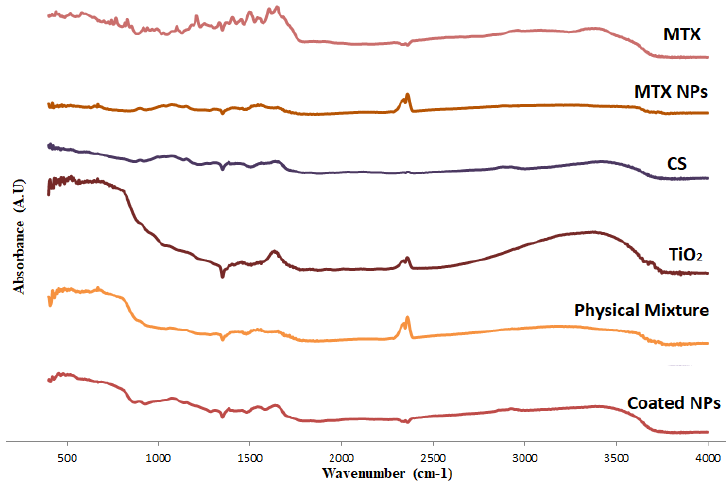
Figure 2. FTIR spectra of CS, MTX, TiO 2 NPs, CS-MTX NPs, the physical mixture (MTX-CS-NPs with TiO 2 NPs) and MTX-CS-NPs coated with TiO 2 NPs.